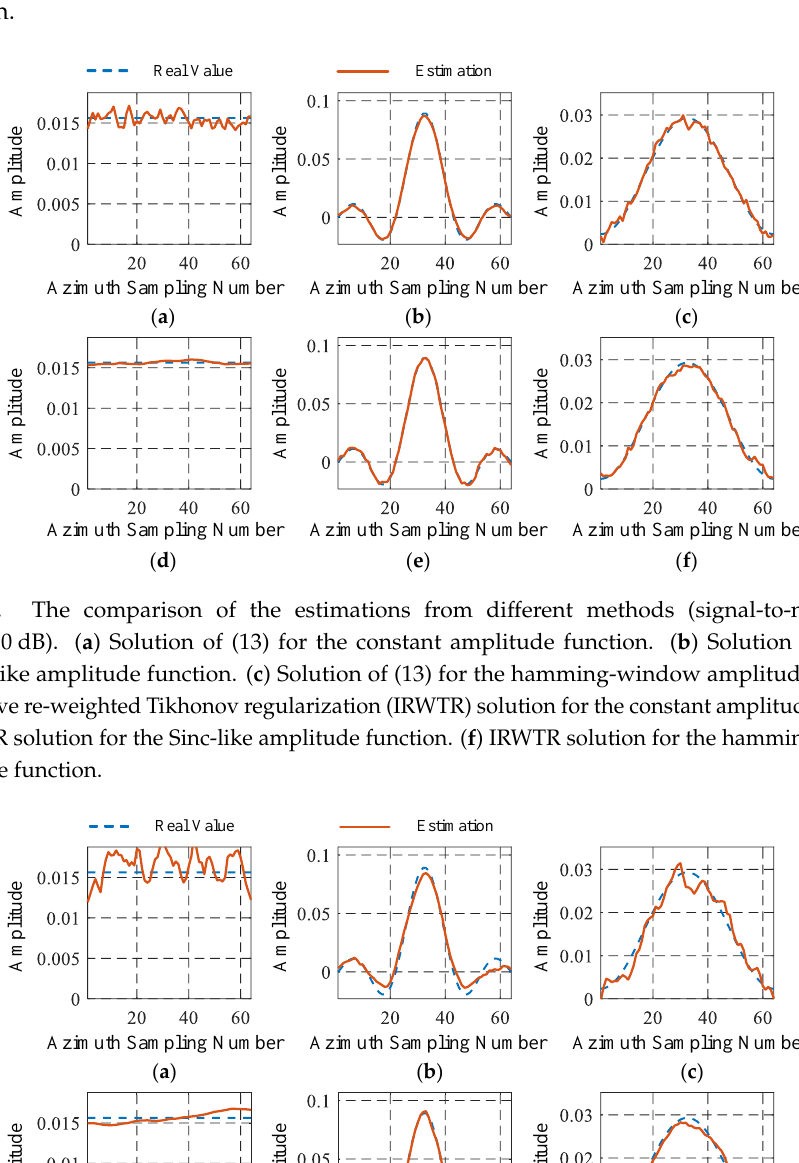
Figure 9. Performance comparison of the methods under different levels of noise. 4.2. The Results of Electromagnetic Simulation Data and Analysis In this section, we apply the proposed processing procedure to the data simulated by FEKO software and the processing results will be shown. The imaging scene is shown in Figure 10, which included two metal rods and three metal balls. The radar transmitted a step sweep frequency signal with a start frequency of 8 GHz, bandwidth 4 GHz. The azimuth start and end angle were − 22.5° and 22.5°. We applied the BP imaging algorithm to the simulation data and the result is shown in Figure 11. In Figure 11, there are only seven points. In fact, we knew that there were two distributed scattering centers in the scene from Figure 10. However, because their specific orientations, we could not recognize these two distributed scattering centers from Figure. 11. We applied the proposed method in Section 3.2 to the data and extract the aspect-dependent amplitudes of all points. The estimated aspect-dependent amplitudes are presented in Figure 12. According to Figure 12, we can find that the amplitudes of certain scatterers were almost independent of the look angle. These scatterers with slowly varying amplitudes were the imaging results of the metal balls, which were the actual local scattering centers. The variations in the amplitude responses of the rest were more